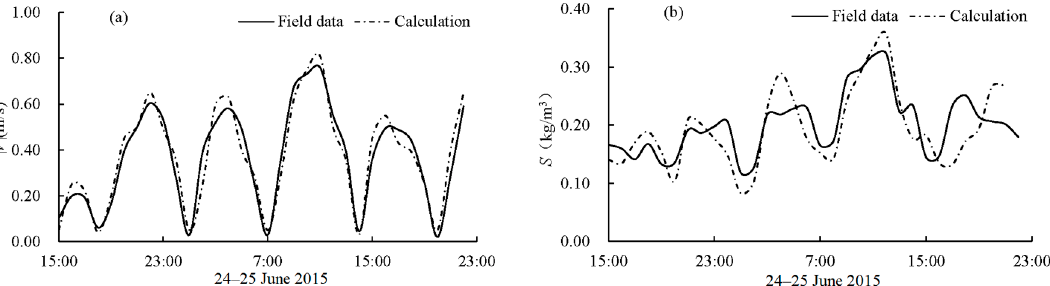
Figure 13. Model validation, numerical results vs. field data at FS3 (neap tide, June 2015): ( a ) |𝑉| ; ( b ) S .